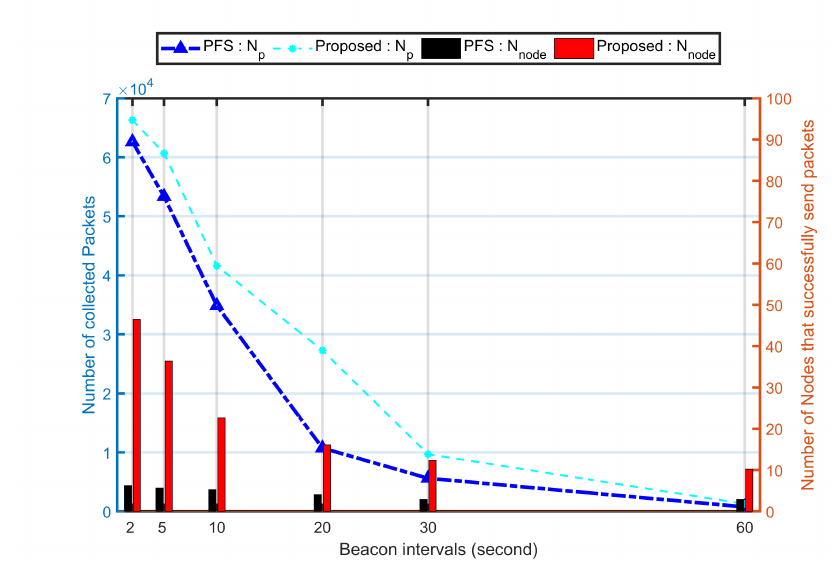
Figure 7. The impact of inter-beacon duration on network performance. In these simulations, the proposed algorithm is the combination of proposed Balance and PCdFS